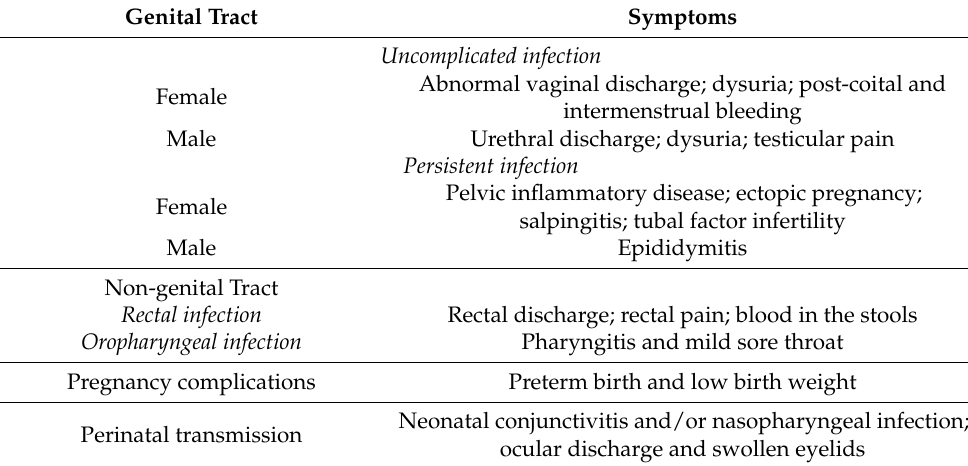
Table 1. The most common symptoms of Ct infection according to gender, condition, and anatomical region infected